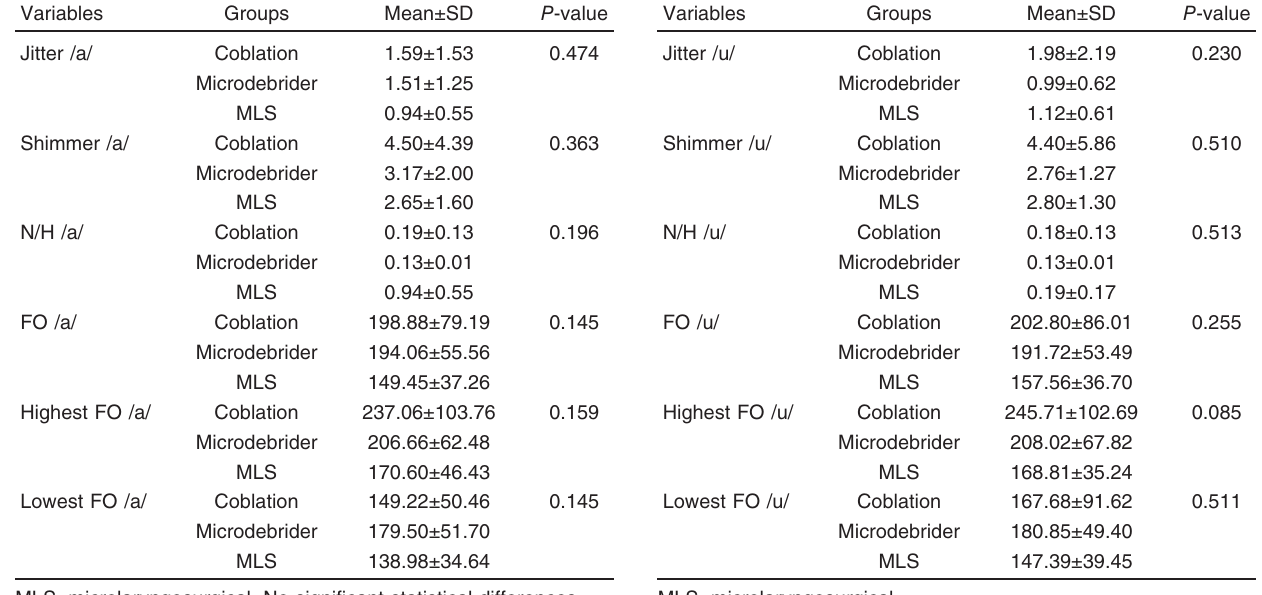
Table 12 Comparison between groups of the study regarding improvement of different variables after intervention /a/ Variables